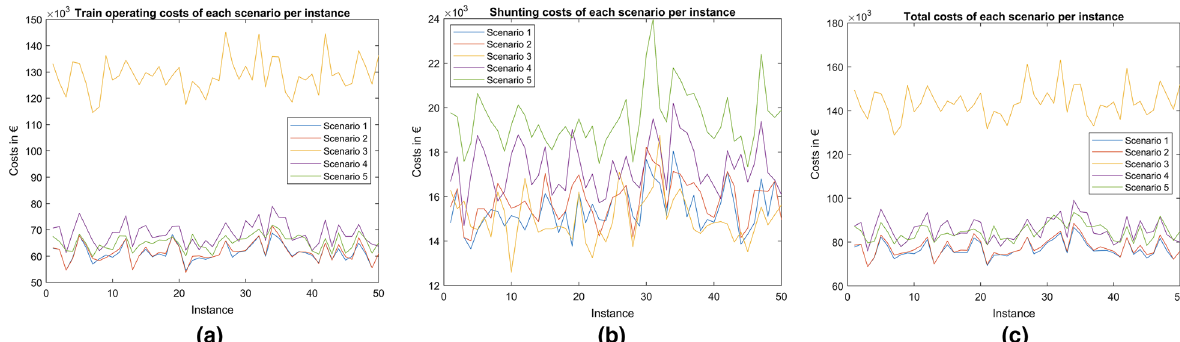
Fig. 3 Train costs, shunting costs and total costs displayed for each computed instance (test series